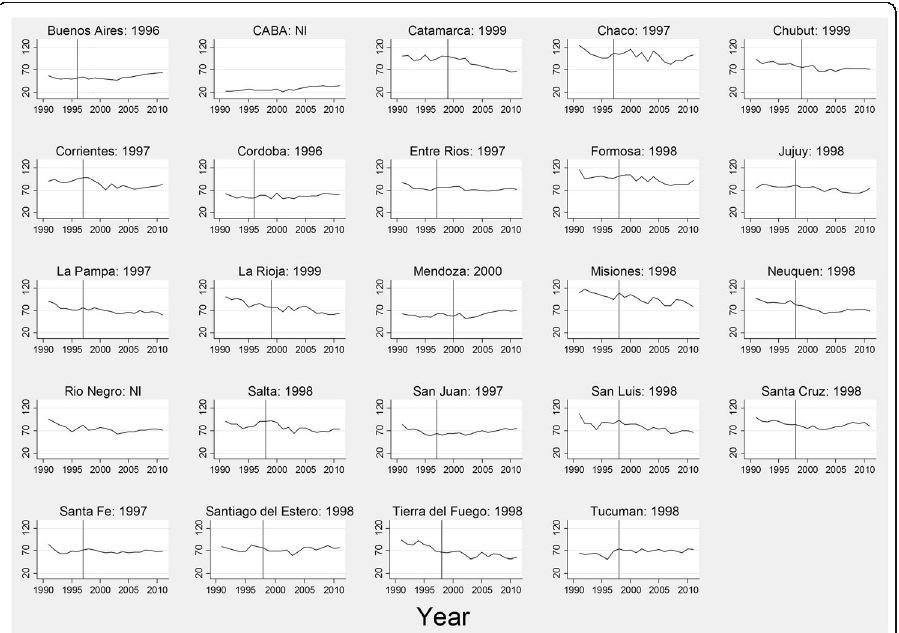
Fig. 5 Teenage fertility rates and implementation of education reform, by province. Argentina, 1991 – 2011 (number of live births per 1000 women aged 15 – 19). Notes: NI not implement, CABA City of Buenos Aires (Federal District). Vertical lines indicate year of implementation of LFE by province. Source: Office of Health Statistics DEIS and Crosta (2007); own calculations